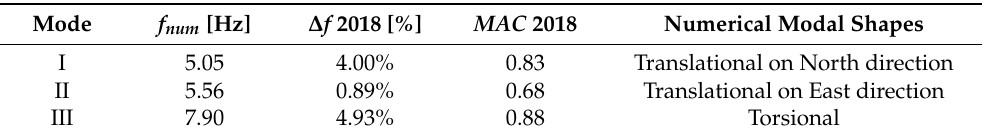
Table 3. Comparison of the modal frequencies and shapes between the starting FEM and the OMA results.